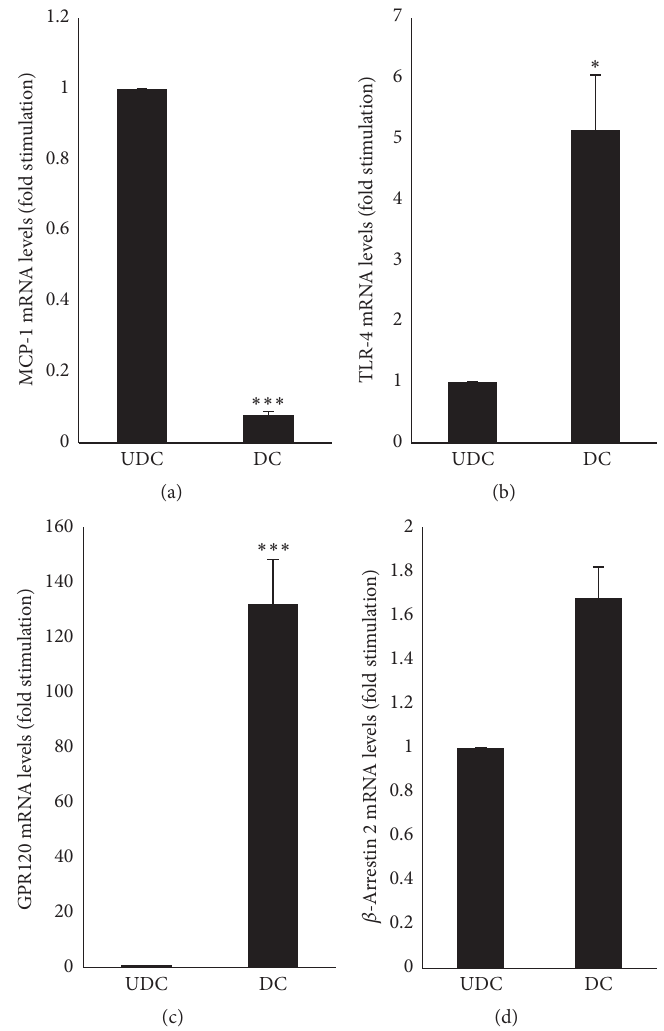
Figure1:ExpressionofmRNAofMCP-1(a),TLR-4(b),GPR120(c),and 𝛽 -Arrestin2(d)inundifferentiatedversusdifferentiated3T3-L1cells. UDC and DC were obtained as described under Materials and Methods. The results are expressed as relative mRNA levels (fold stimulation over UDC set to 1) and are the means ± SEM of 3 independent experiments. Data were analyzed by 𝑡 -test for unique sample; ∗ 𝑝 < 0.05 and ∗∗∗ 𝑝 < 0.005 versus